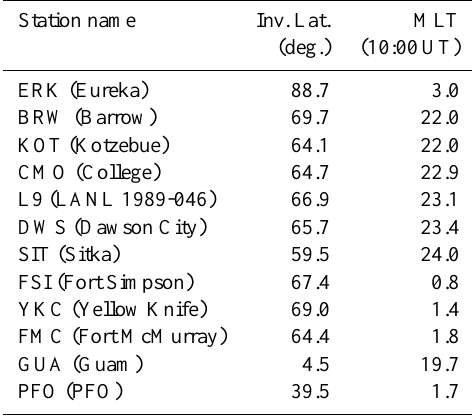
Table 1. Invariant latitudes and MLT of ground stations and satellite footprints at